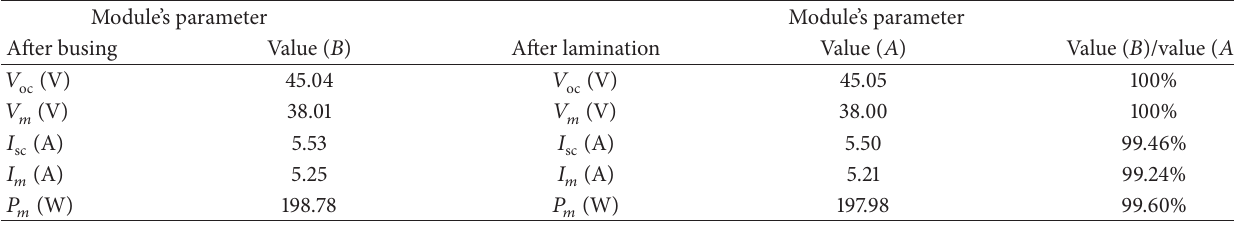
Table 5: Comparison of the electrical parameters after busing and before lamination.